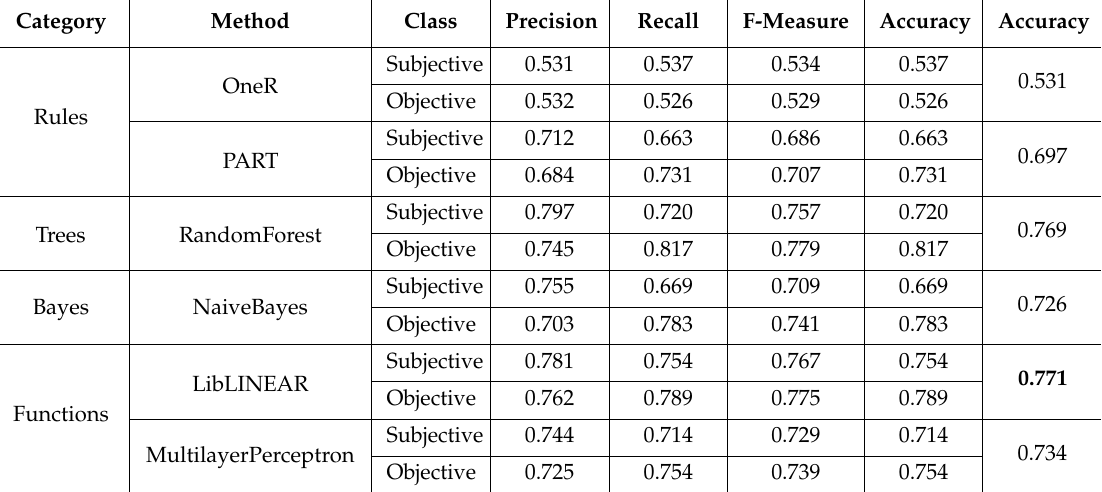
Table 9. Results for combined